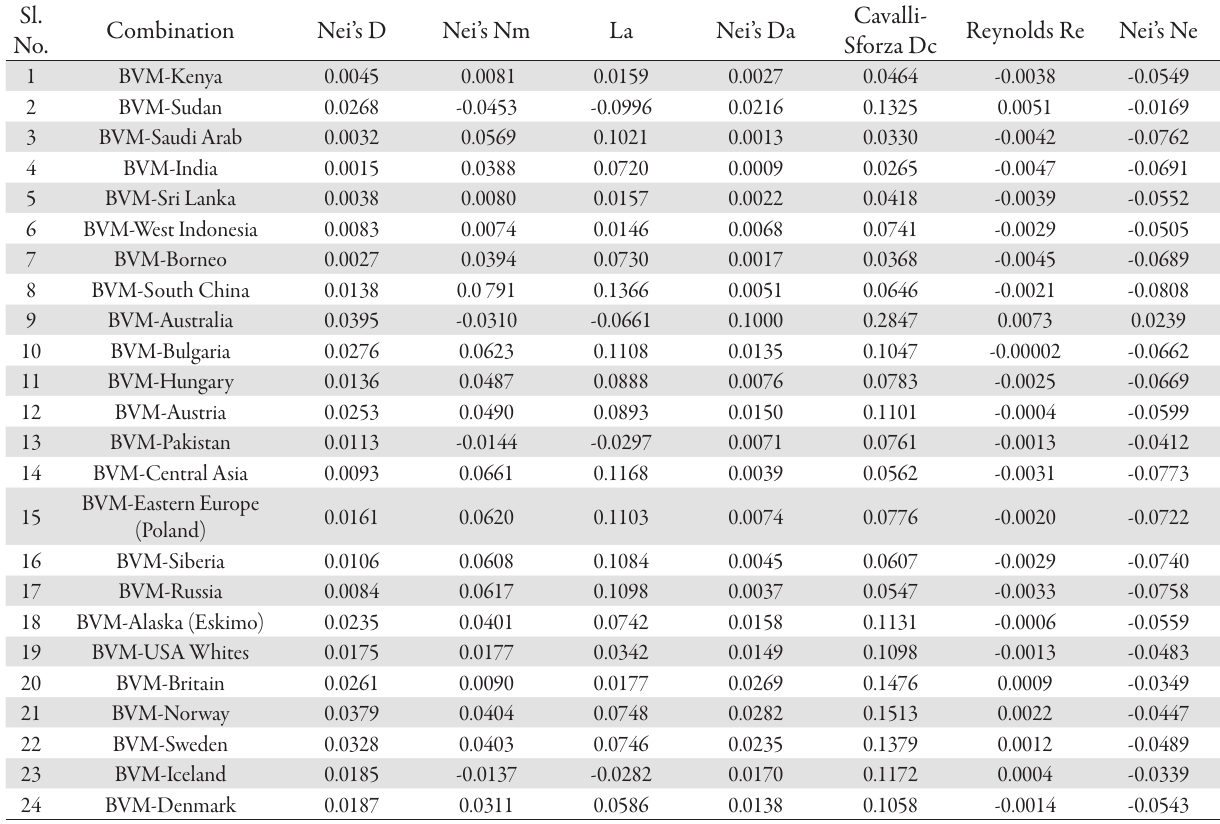
Tab. 2. Estimates of seven different genetic distance measures between BVM and other nations for ABO gene Sl.